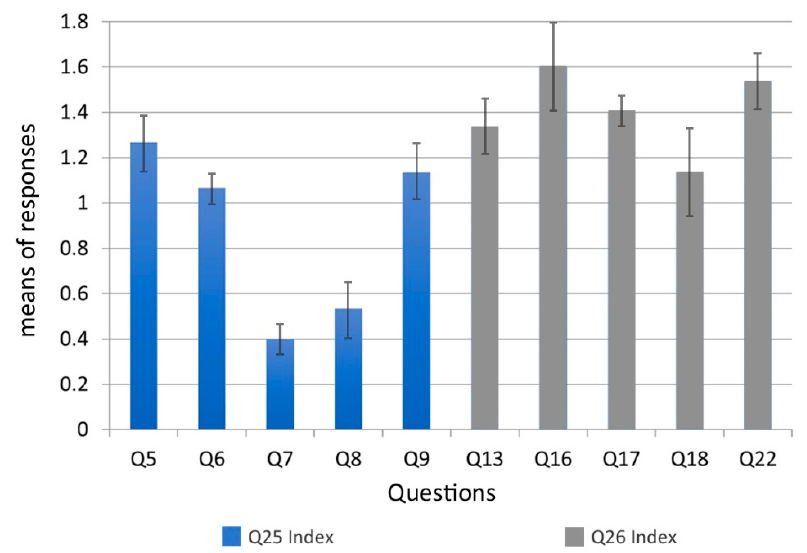
Figure 8. Graphical representation of the means of responses to key questions in the evaluation questionnaire.